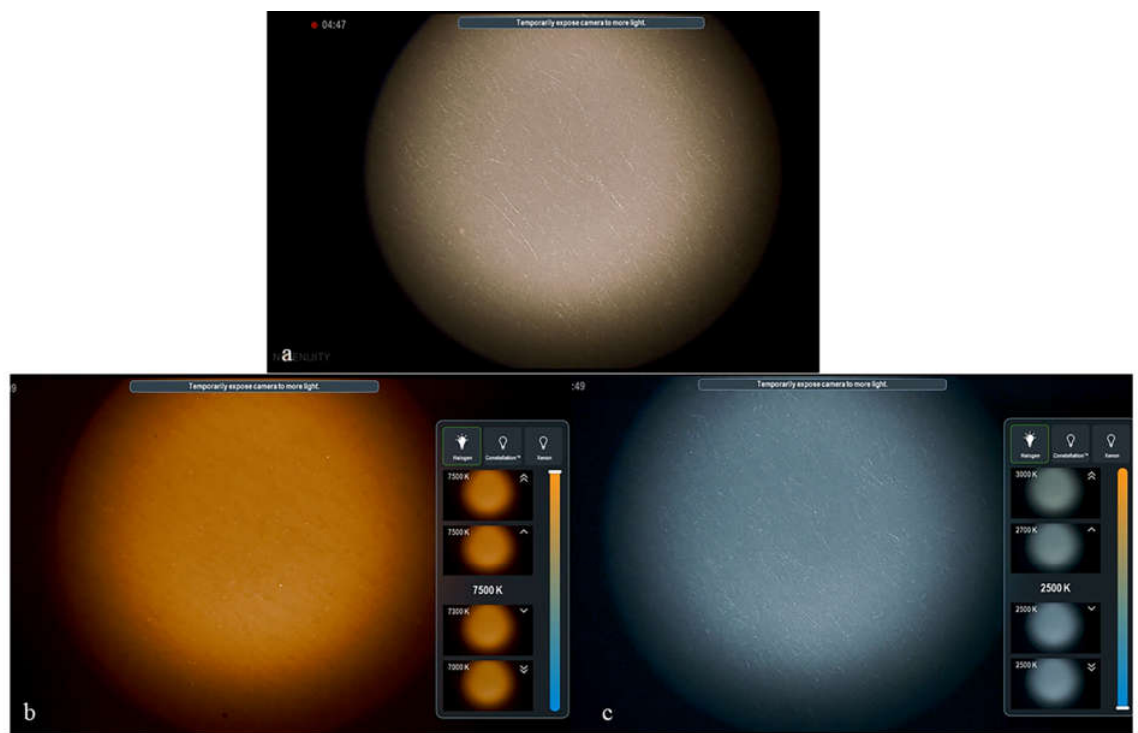
Figure 5. Effect of changing color temperature with the Ngenuity system on the appearance of a sheet of white paper ( a ). The paper takes on a warm, orange tint when the color temperature is increased to 7500 K ( b ) and a blue cool tint when the color temperature is decreased to 2500 K ( c ).